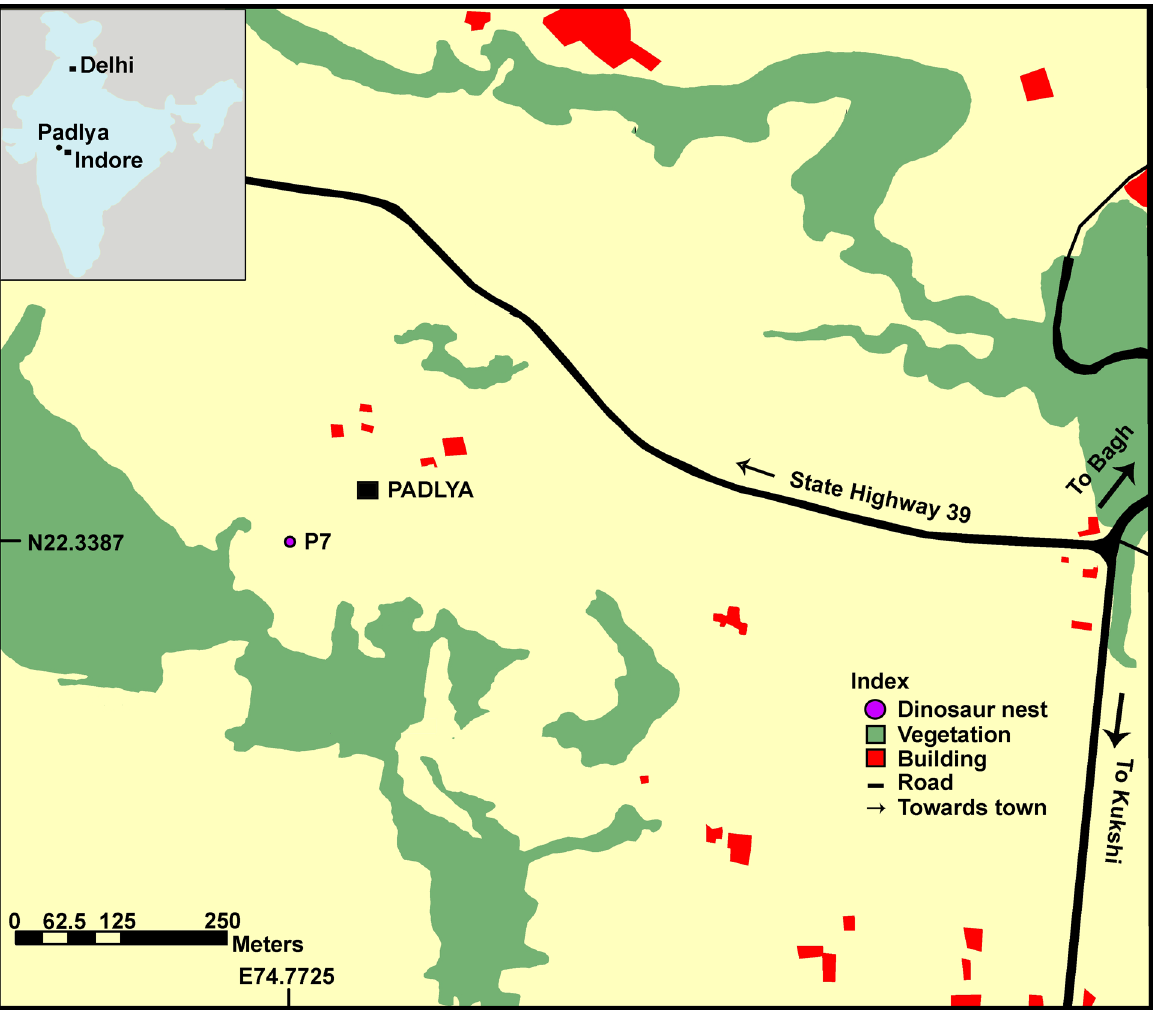
Figure 2. Location map of the study area showing pathologic dinosaur nest P7 from the village Padlya, Dhar District, Madhya Pradesh, India (software used Adobe Illustrator